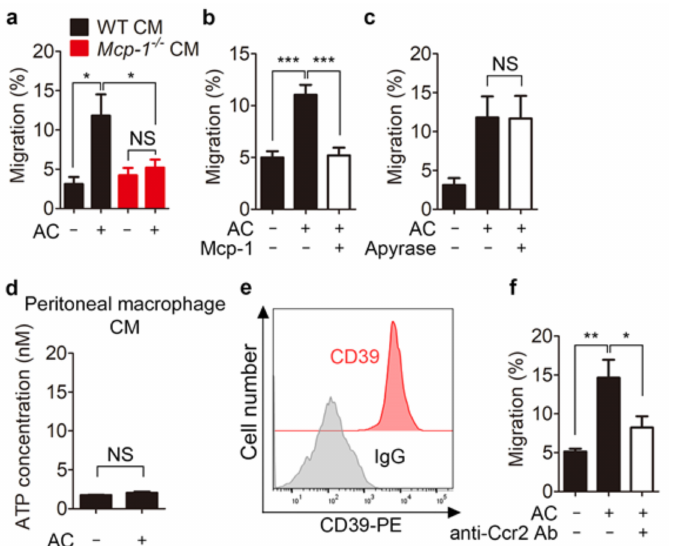
Figure 3. Conditioned medium from phagocytes during efferocytosis attracts monocytes in a Mcp-1- dependent manner. ( a ) Migration of THP-1 monocytes through a transwell to conditioned medium from WT or Mcp-1 − / − peritoneal macrophages incubated with or without apoptotic cells was measured. The percentages of input monocytes that migrated to the lower chamber are shown. ( b ) Pure Mcp-1 (50 ng/mL) was added to the upper well along with THP-1 cells, and migration was assessed toward conditioned medium from phagocytes incubated with apoptotic cells placed in the lower chamber. ( c ) Conditioned medium derived from phagocytes incubated with apoptotic cells was treated with or without apyrase, and then migration of THP-1 cells toward the conditioned medium was assessed. ( d ) ATP concentration in conditioned medium derived from phagocytes incubated with or without apoptotic cells were measured using a colorimetric method. ( e ) Peritoneal macrophages were stained with a PE-conjugated anti-CD39 antibody or isotype control antibody, and analyzed by flow cytometry. ( f ) THP-1 cells were pretreated with an anti-Ccr2 antibody. Migration of THP-1 cells toward conditioned medium derived from phagocytes incubated with apoptotic cells was evaluated as in a. All data are shown as the mean ± SEM. * p < 0.05, ** p < 0.01, *** p < 0.001. NS, not significant; CM, conditioned medium; AC, apoptotic cells; Ab,